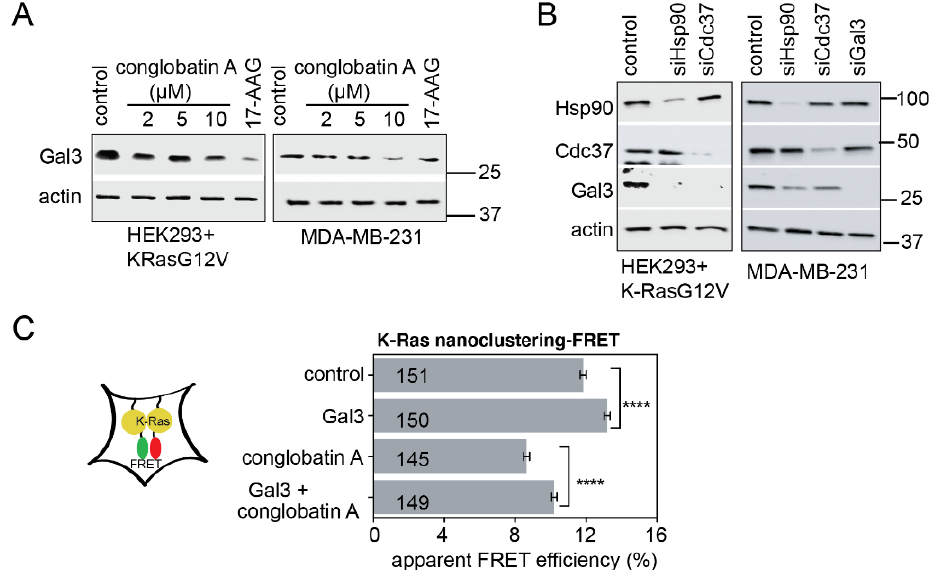
Figure 3. Conglobatin A depletes the K-Ras nanocluster scaffold galectin-3 via HIF-1. ( A ) Western blots of HEK cells transfected with mGFP-K-RasG12V, and of MDA-MB-231 cells treated with either 0.1% DMSO vehicle control or with the indicated concentrations of conglobatin A. In total, 2 µ M 17-AAG served as the positive control. All of the drug treatments were for 24 h; n = 3 independent biological repeats. ( B ) Western blots of the HEK cells transfected with mGFP-K-RasG12V, and of MDA-MB-231 cells 48 h after knockdown using 50 nM for scramble control, siHsp90, siCdc37 or 25 nM for siGal3; n = 2 independent biological repeats. ( C ) K-RasG12V nanoclustering-FRET in HEK cells co-transfected with mGFP- and mCherry-tagged K-RasG12V. At the same time, Galectin-3 was expressed from 600 ng/mL pcDNA3.1-galectin-3 for 24 h. The cells were then treated with 2 µ M conglobatin A for 24 h; n = 3 independent biological repeats. **** p < 0.0001.